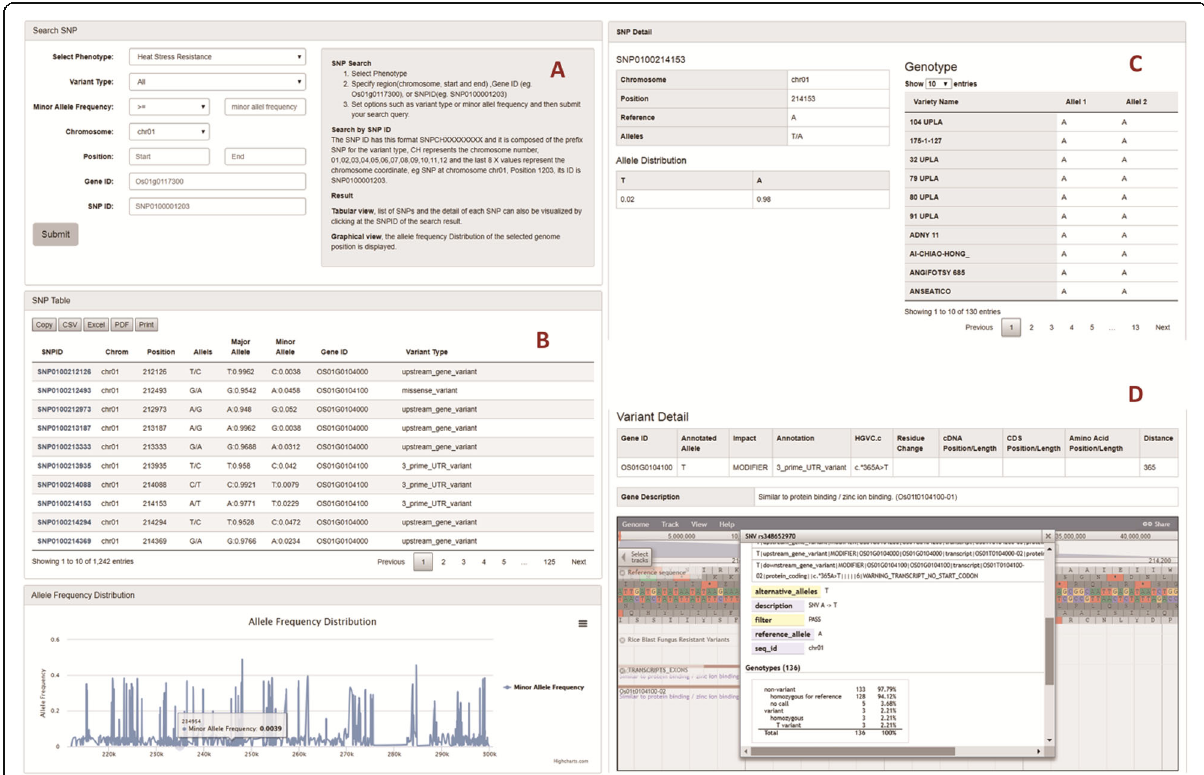
Fig. 6 Examples of search functions in RSRS database. Search Interface ( a ) allows users to search by region, gene ID and SNP ID. Additionally users can also set options, such as allele frequency, variant types. Search Results ( b ) retrieves the list of SNPs and displays the allele distribution in a given range. SNP detail view ( c ) displays the detail of each SNP and the genotype of each rice accession. Jbrowse visualization ( d ) displays